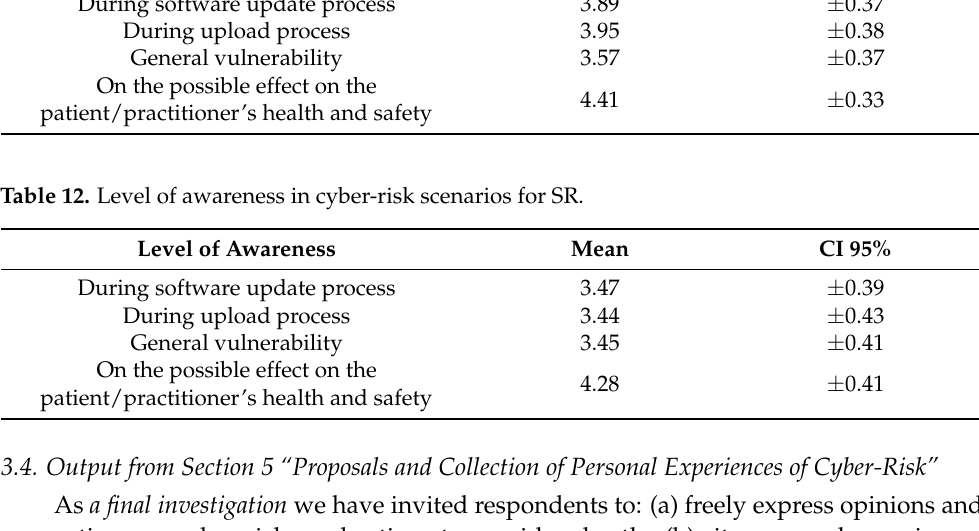
Table 11. Level of awareness in cyber-risk scenarios for BA. Level of Awareness